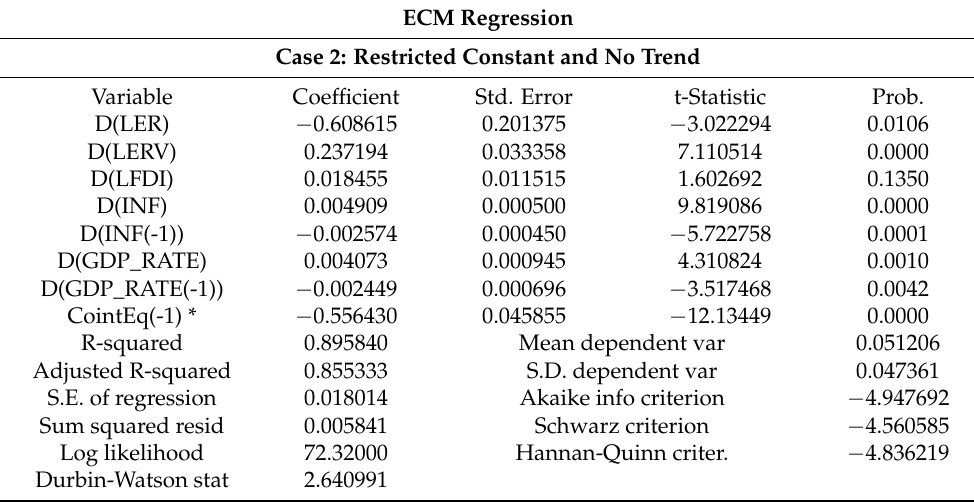
Table 6. Error Correction Model and short-term coefficients of the